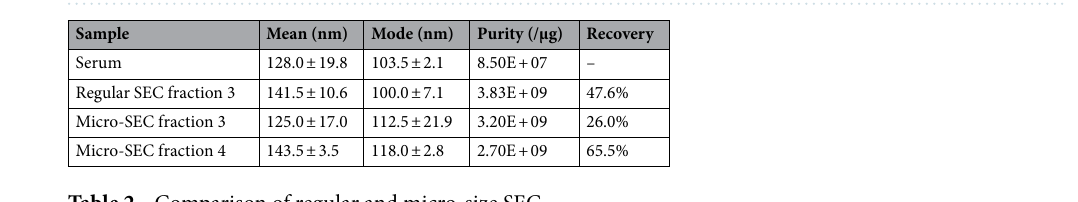
Table 2. Comparison of regular and micro-size SEC.